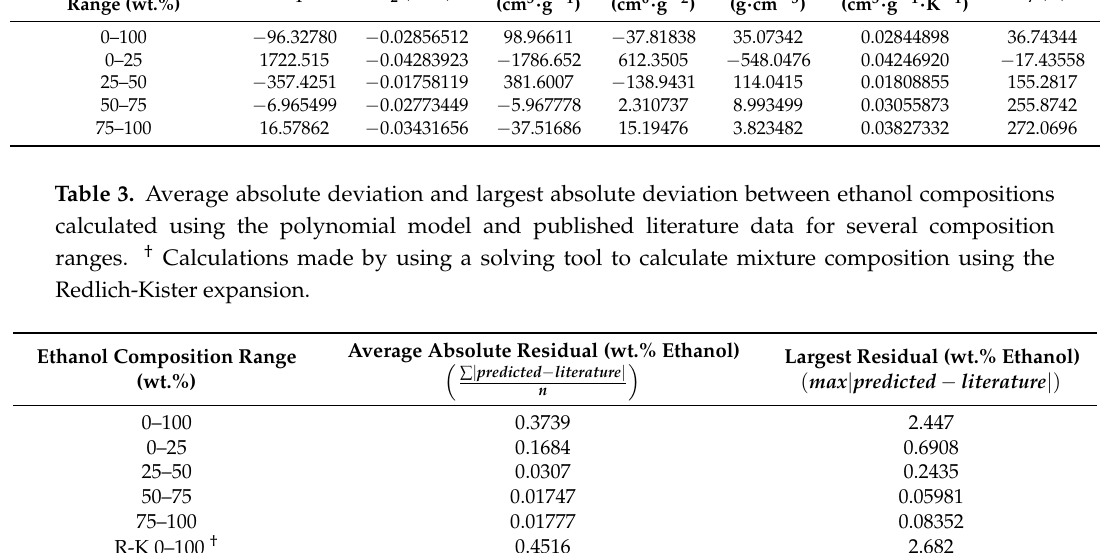
Table 2. Optimized coefficients for the polynomial model shown in Equation (8). Ethanol Composition Range (wt.%)